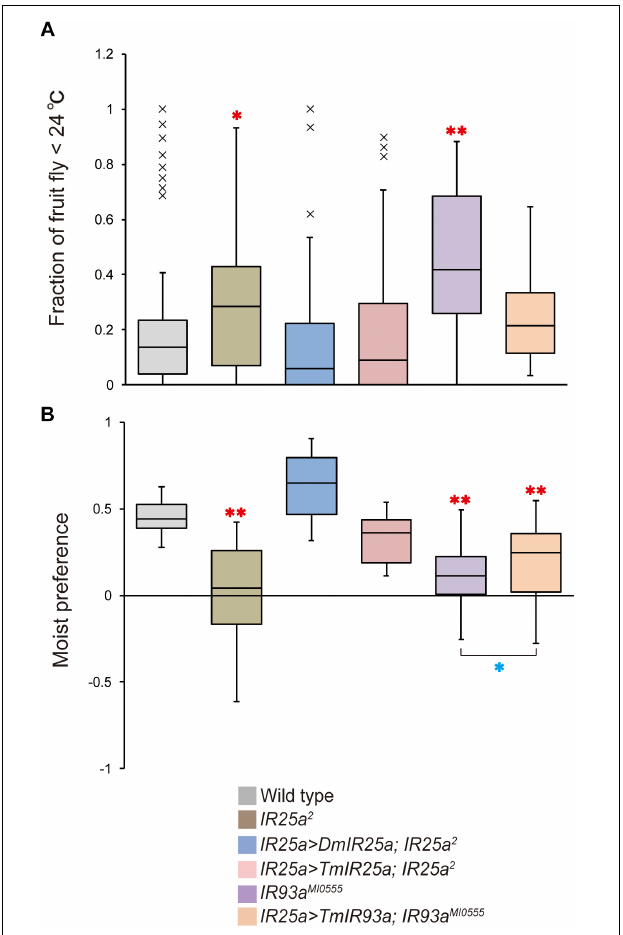
FIGURE 4 | TmIR25a and TmIR93a rescue the behavioral defects of Drosophila melanogaster IR25a and IR93a mutants. (A) The fraction of wild type ( n = 108), IR25a 2 ( n = 148), IR25a 2 expressing either DmIR25a (IR25a > DmIR25a; IR25a 2 ) ( n = 63) or TmIR25a (IR25a > TmIR25a; IR25a 2 ) ( n = 50), IR93a MI0555 ( n = 75), and IR93a MI0555 expressing TmIR93a (IR25a > TmIR93a; IR93a MI0555 ) ( n = 60) under IR25a-Gal4 in the area < 24 ◦ C of the thermal gradient. Red asterisks ( ∗ and ∗∗ ) are significantly different from wild type, and P -values for IR25a 2 and IR93a MI0555 are < 0.03 and < 0.001, respectively (two-tailed Dunnett test). (B) Moist preference (70 over 20% humidity) of fruit flies of above genotypes is shown ( n = 39, 27, 9, 9, 39, 39 for wild type, IR25a 2 , IR25a > DmIR25a; IR25a 2 , IR25a > TmIR25a; IR25a 2 , IR93a MI0555 , and IR25a > TmIR93a; IR93a MI0555 , respectively). Red asterisks ( ∗∗ ) are significantly different from wild type ( P -value < 0.001, two-tailed Dunnett test) and blue asterisk ( ∗ ) indicates significant difference between IR93a MI0555 and IR25a > TmIR93a; IR93a MI0555 ( P -value < 0.03, two-tailed Welch’s t -test).